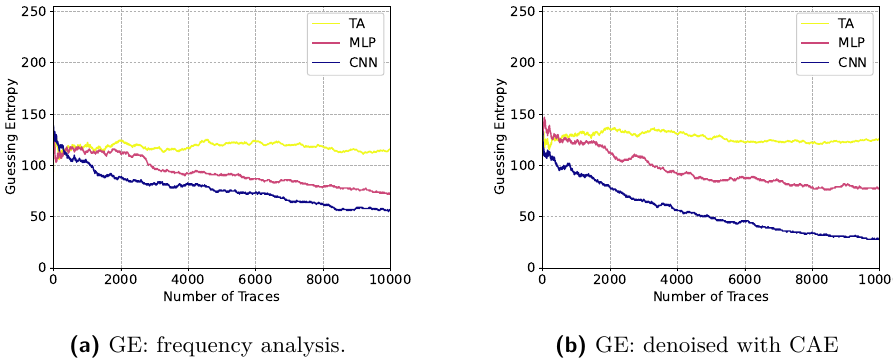
Figure 12: Guessing entropy: denoising combined noise with frequency analysis vs